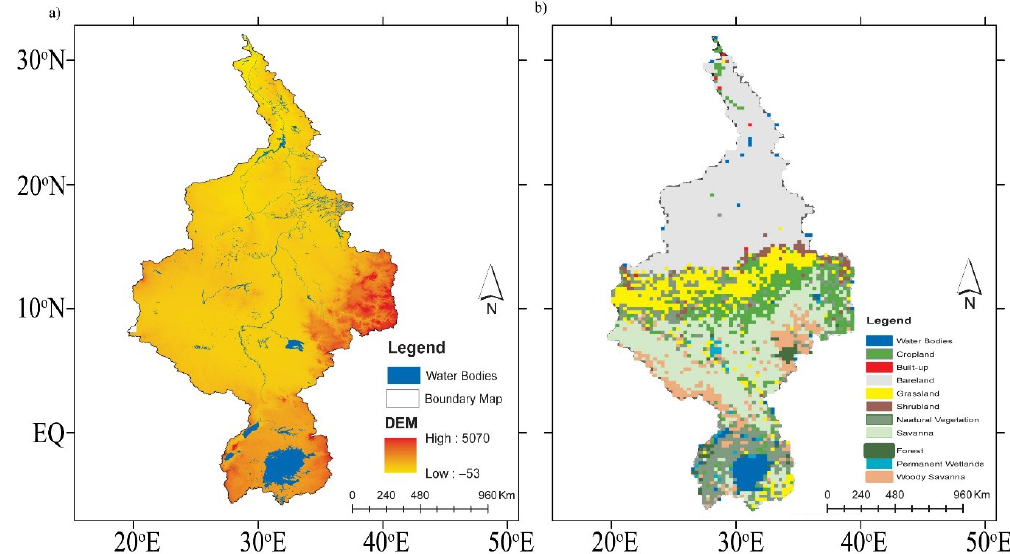
Figure 1. Nile Basin: ( a ) 30 m Shuttle Radar Topography Mission (SRTM) Digital Elevation Data (DEM)